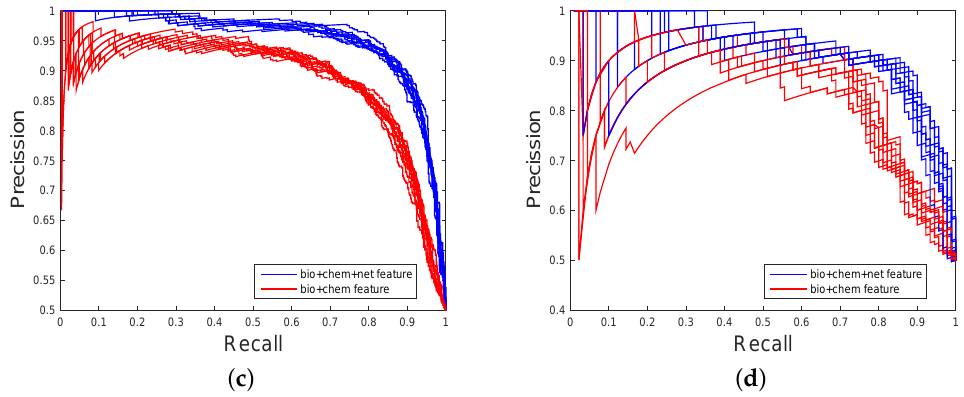
Figure 2. The area under the precision–recall (PR) curve (AUPR) values obtained on balanced datasets (with FS). The blue curve is the combined feature of MACCS (chem), DWT (bio), and net. The red curve is the combined feature of MACCS (chem) and DWT (bio); ( a ) Enzyme’s PR curve with network feature; ( b ) IC’s PR curve with network feature; ( c ) GPCR’s PR curve with network feature; ( d ) Nuclear receptor’s PR curve with network feature.